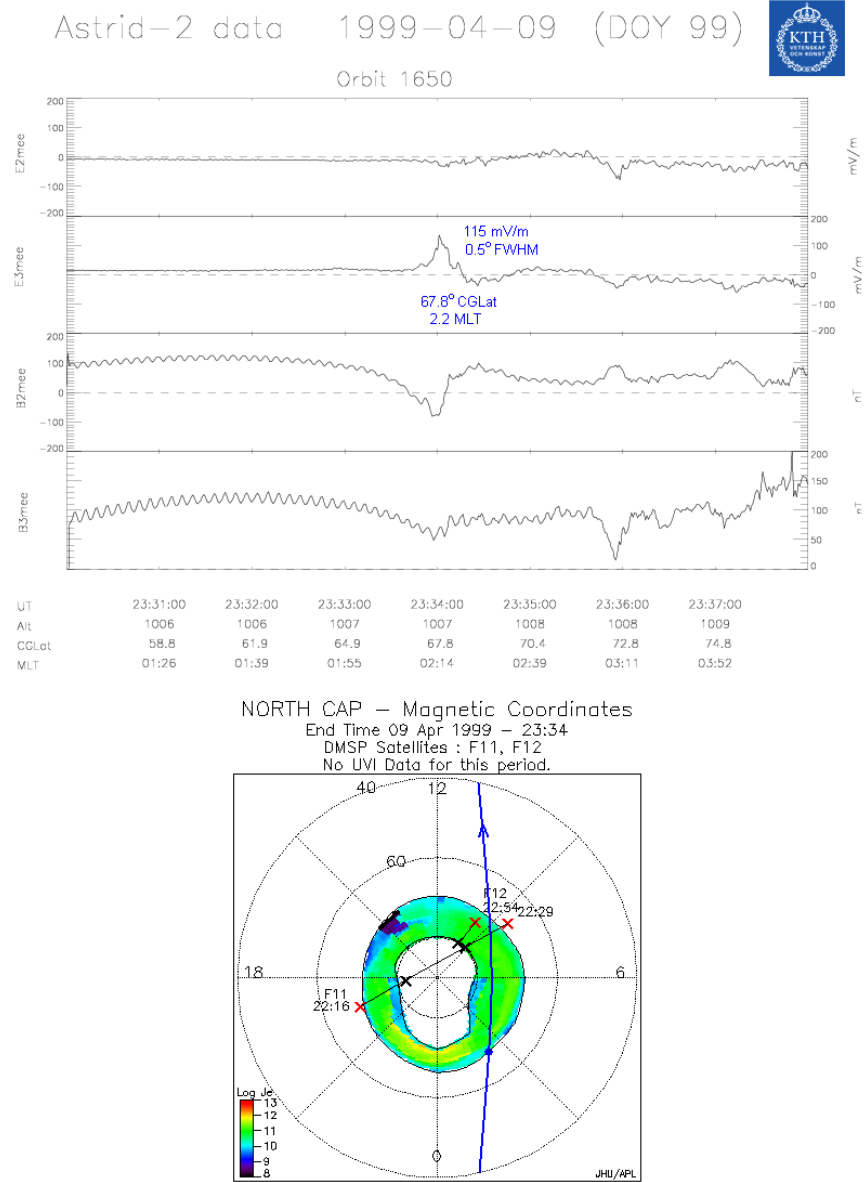
Fig. 2. The upper plot shows the eastward and the equatorward components of the electric and magnetic fields (panels 1, 2, 3, and 4, respectively), measured on 9 April 1999 between 23:30 and 23:38UT. Universal time, altitude in kilometers, CGLat and MLT are given on the horizontal axis. In the lower part is shown a polar plot of the position of the auroral oval determined using the OVATION tool. The differential energy flux of the precipitating electrons in units of log10eV/cm 2 sstr is color coded. The orbit of the Astrid-2 satellite between 23:25 and 23:55UT is overlaid with a blue line. The location of the ASAID peak measured at 23:34UT is marked with a dot on the satellite